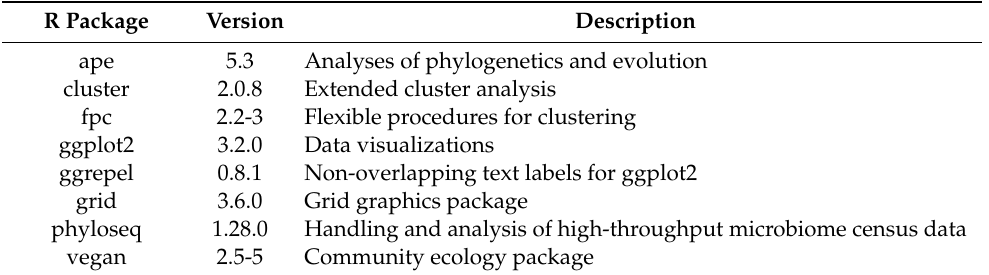
Table 3. List of additional R packages used for the calculation and graphical representation of the Manhattan